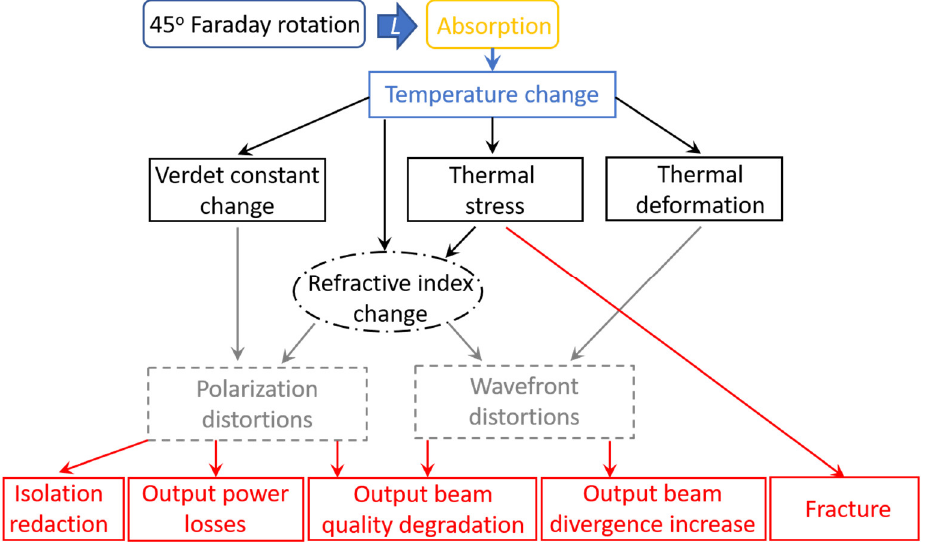
Figure 2. A simplified scheme of the physical phenomena involved in the absorption-induced thermal effects in magneto-optical media.